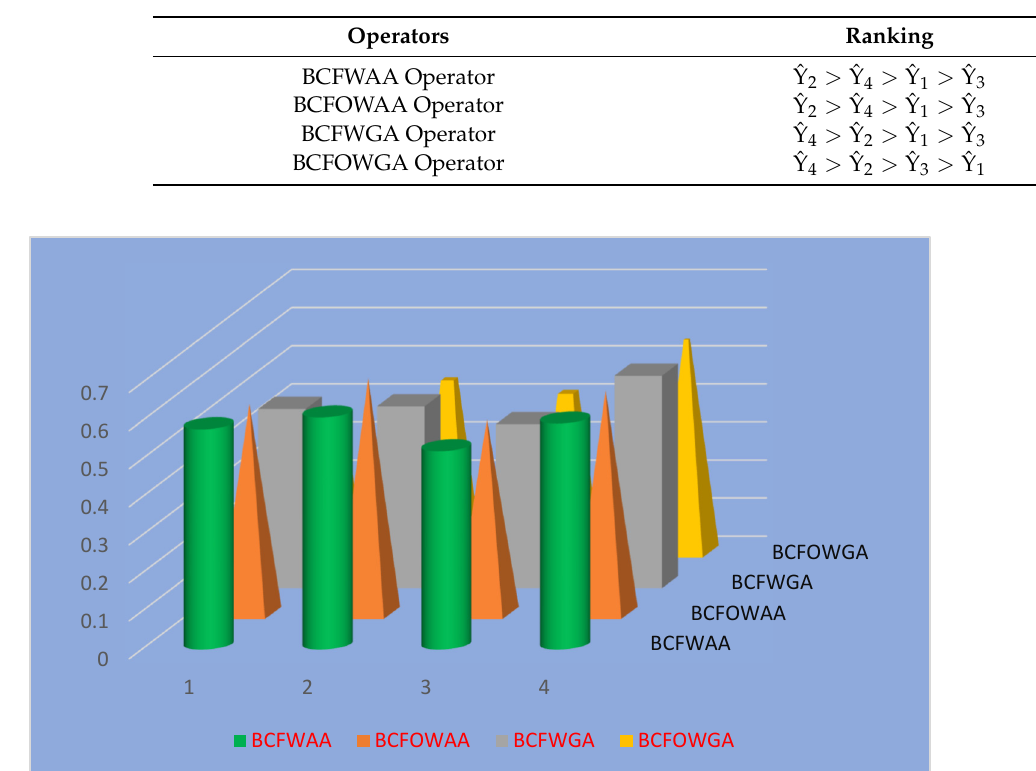
Figure 3. A graphical depiction of the information discussed in Table 3.